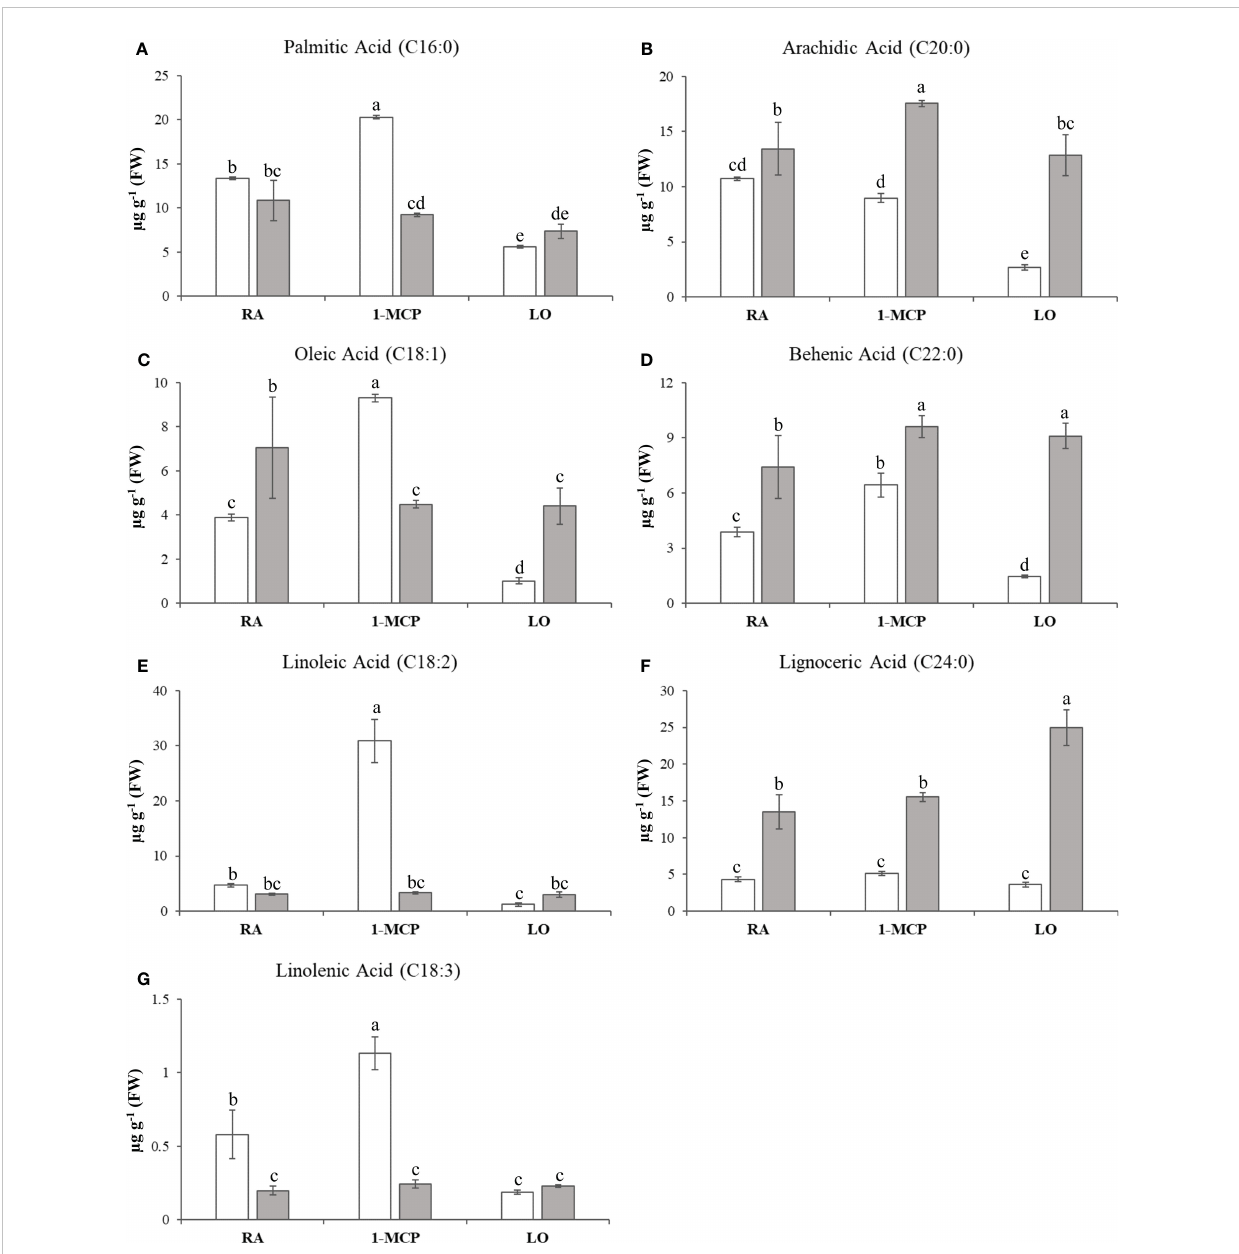
FIGURE 3 Lipids quanti fi cation in ‘ Granny Smith ’ (white bar) and ‘ Ladina ’ (grey bar) apple cultivars. (A) palmitic acid, (B) arachidic acid, (C) oleic acid, (D) behenic acid, (E) linoleic acid, (F) lignoceric acid and (G) linolenic acid. The concentration was express as µg·g -1 of fresh weight (FW). The error bars correspond to the standard deviation. RA, Regular Atmosphere; 1-MCP, Regular Atmosphere + 1-MCP treatment; LO, Low Oxygen condition. Fisher ’ s least signi fi cant difference (LSD) test was applied, p-value ≤ 0.01. Different letters indicate difference statistically signi fi